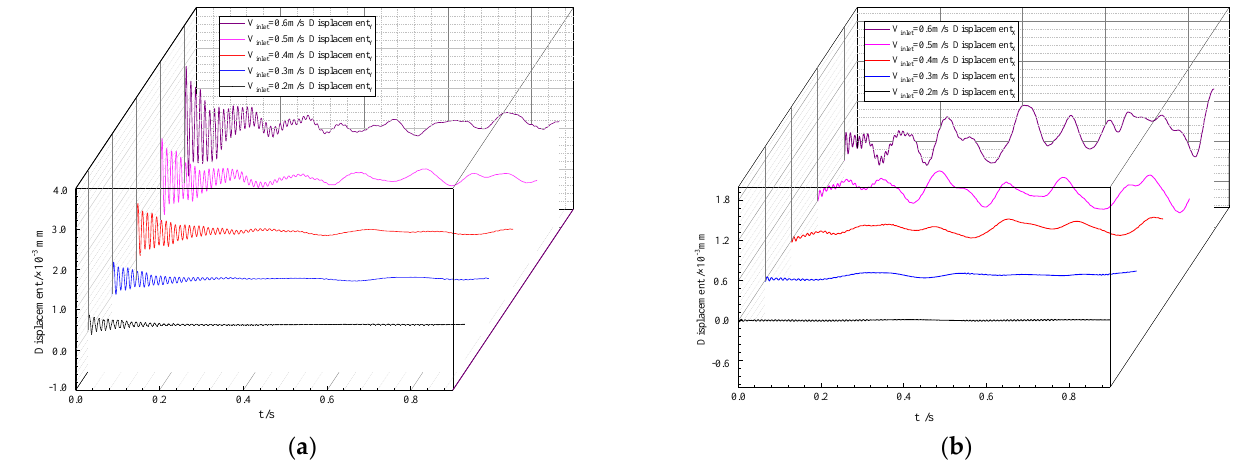
Figure 10. C3 displacement.